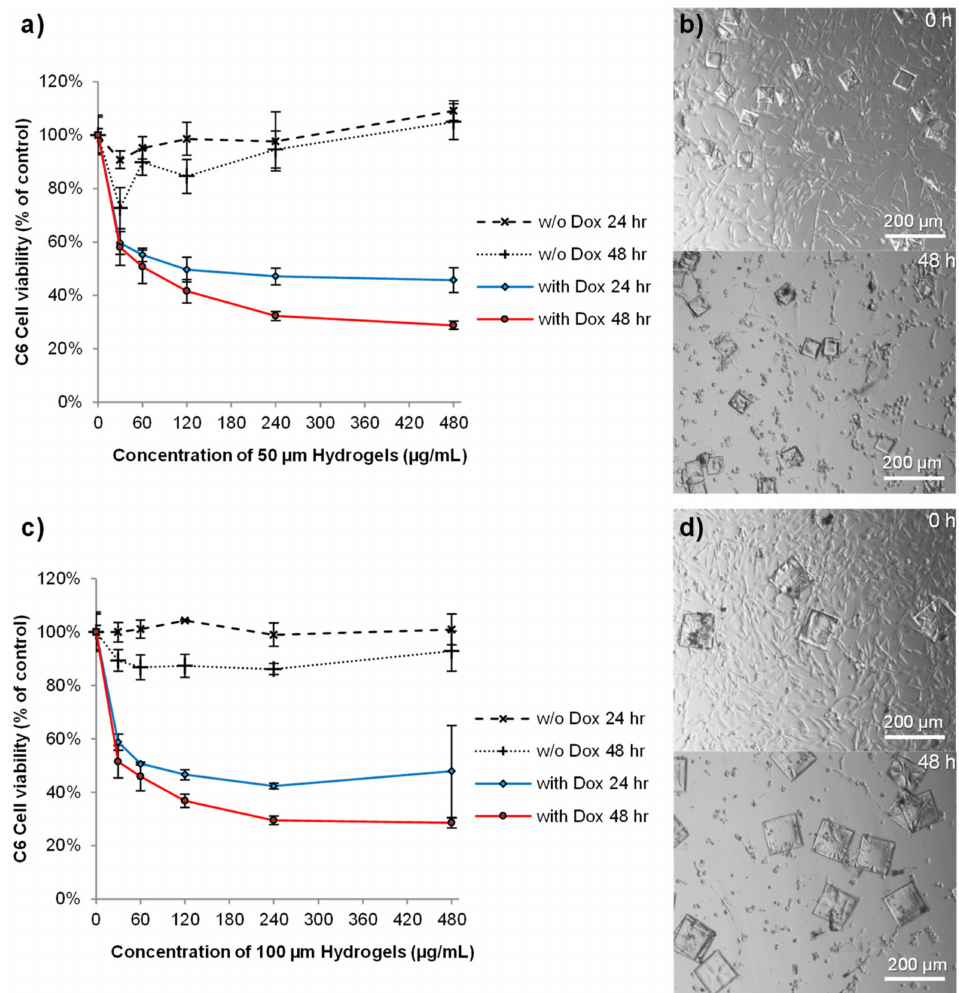
Figure 5. Doxorubicin-loaded microscale hydrogels reduce glioma cell viability, whilst unloaded hydrogels are not cytotoxic. PrestoBlue ® analysis of C6 glioma cell viability for 50 µ m-width hy- drogels ( a ) and 100 µ m-width hydrogels ( c ) showed that unloaded hydrogels were not toxic at any concentration analyzed, yet, reduced cell viability in a dose-dependent manner when loaded with doxorubicin ( n = 4, error bars represent ± standard deviation). Light microscope images of 50 µ m-width hydrogels ( b ) and 100 µ m-width hydrogels ( d ) loaded with doxorubicin, immediately after addition of the hydrogels at a concentration of 480 µ g/mL and then again after 48 h. Scale bars represent 200 µ